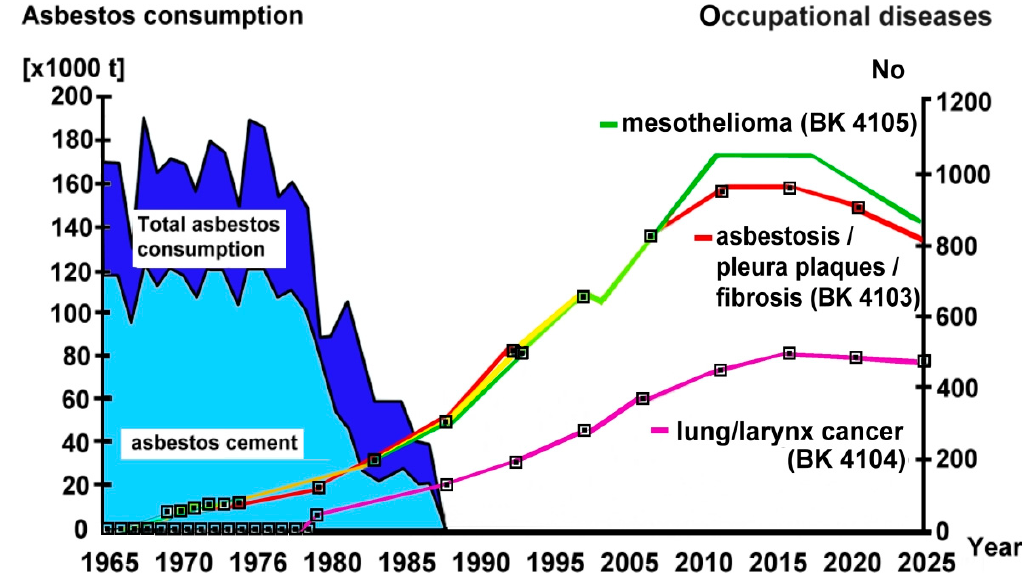
Figure 1. Asbestos consumption and recognized occupational diseases in West Germany (BRD), modified from [4]. In East Germany (DDR), the plateau of asbestos consumption was about 75,000 metric tons annually in 1975–1980. BK = occupational disease designation. Note, that past and current disease data were used for future estimates [4]. For evidence of underreporting of asbestos-related lung cancer see legend of Table 4.